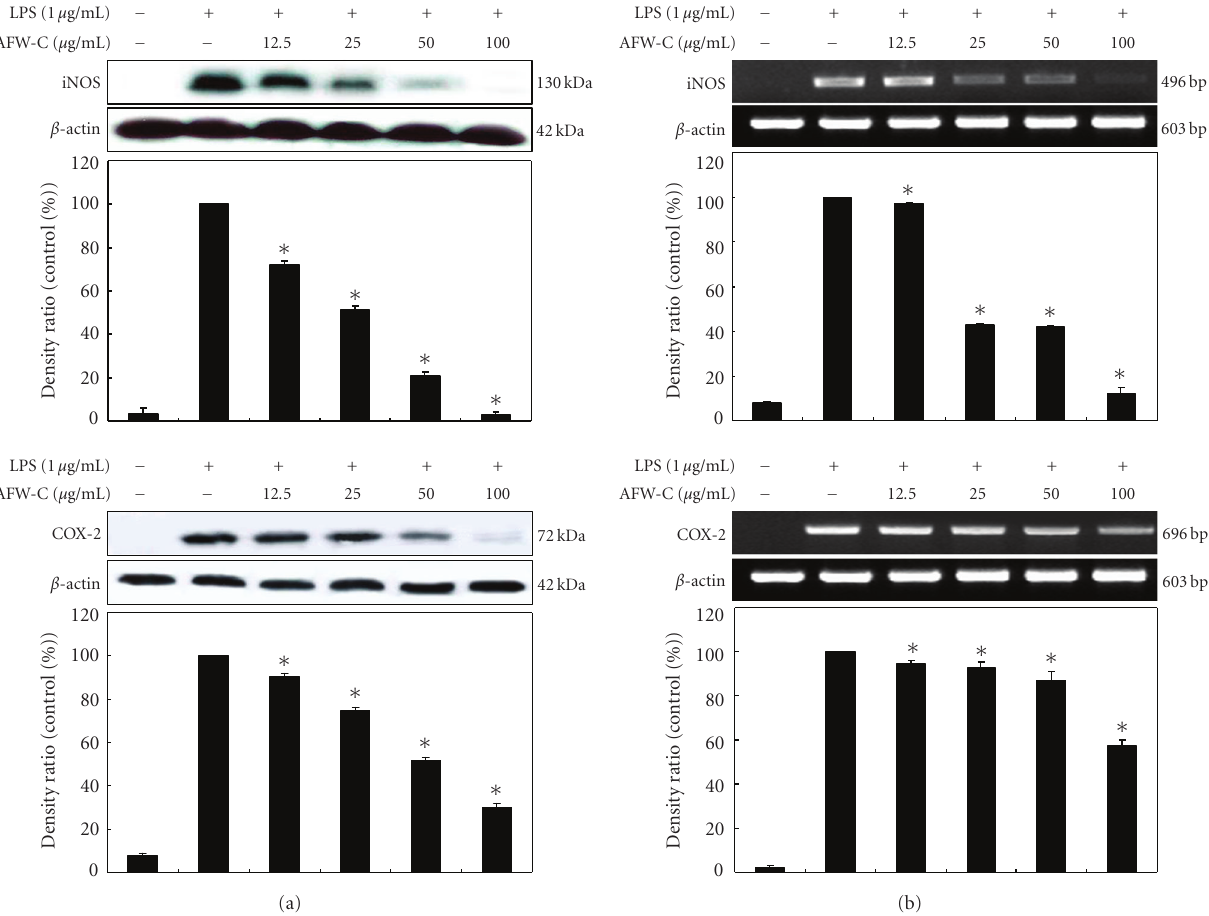
Figure 5: E ff ect of CH 2 Cl 2 fraction of Acanthopanax koreanum fruit waste on the mRNA expression and protein levels of iNOS (a) and COX-2 (b) in LPS-stimulated RAW 264.7 cells. RAW 264.7 cells (5.0 × 10 5 cell/mL) were stimulated with LPS (1 μ g/mL) and the CH 2 Cl 2 fraction of A. koreanum (12.5, 25, 50, 100 μ g/mL) for 24 hours. The mRNA expression of iNOS and COX-2 was determined by RT-PCR. For the western blot analysis, RAW 264.7 cells (1.0 × 10 6 cell/mL) were stimulated with LPS (1 μ g/mL) in the presence of A. koreanum (12.5, 25, 50, 100 μ g/mL) for 24 hours. Whole-cell lysates (25 μ g) were prepared and the protein was subjected to 10% SDS-PAGE; expression of iNOS, COX-2 and β -actin were determined by western blotting. β -Actin served as a loading control. The mRNA expression of iNOS and COX-2 was determined by RT-PCR.